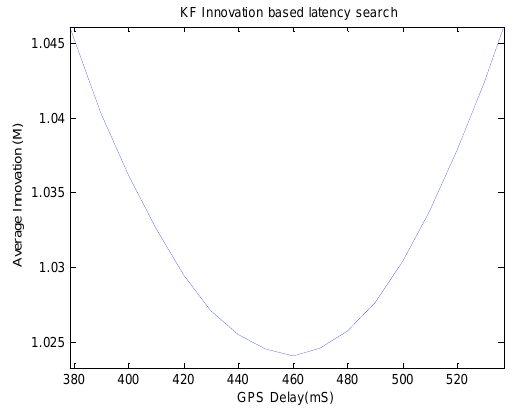
Figure 6 - Zoom of latency